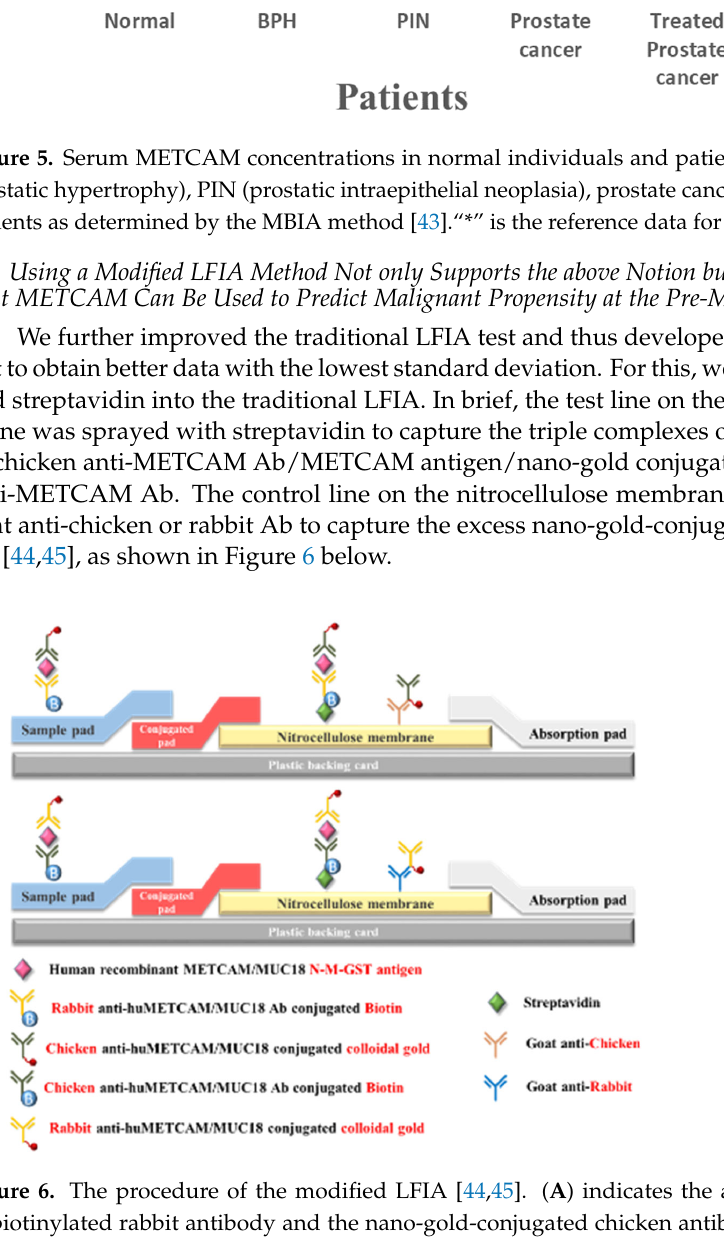
Figure 5. Serum METCAM concentrations in normal individuals and patients with BPH (benign prostatic hypertrophy), PIN (prostatic intraepithelial neoplasia), prostate cancer, and various treated patients as determined by the MBIA method [43].“*” is the reference data for statistical analysis.